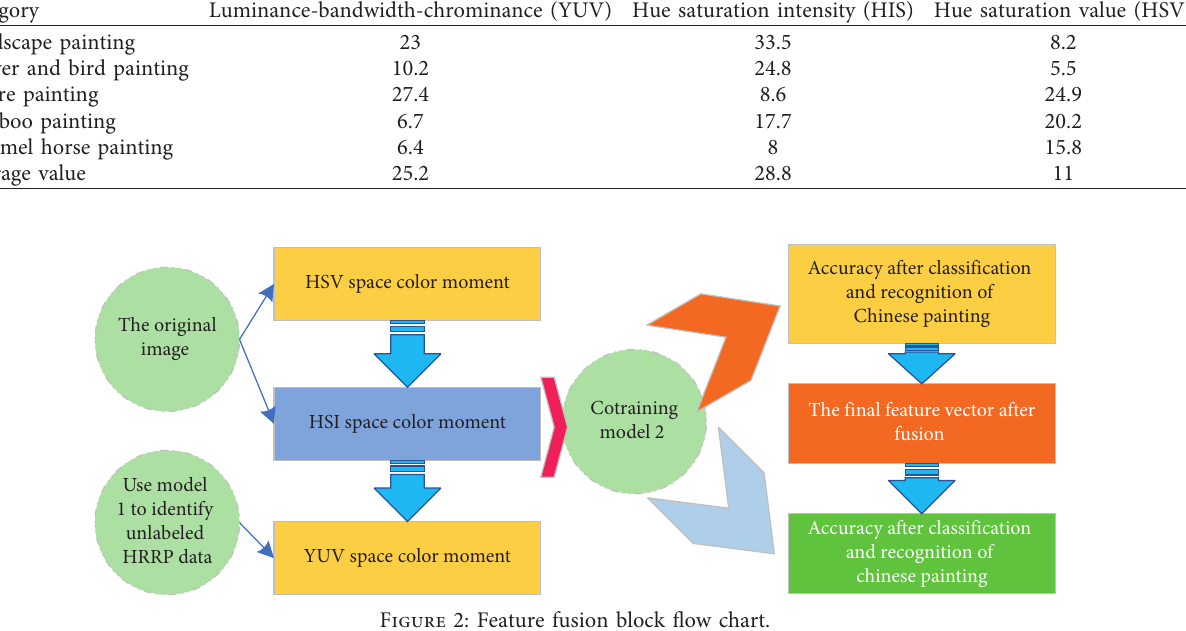
Figure 2: Feature fusion block flow chart.